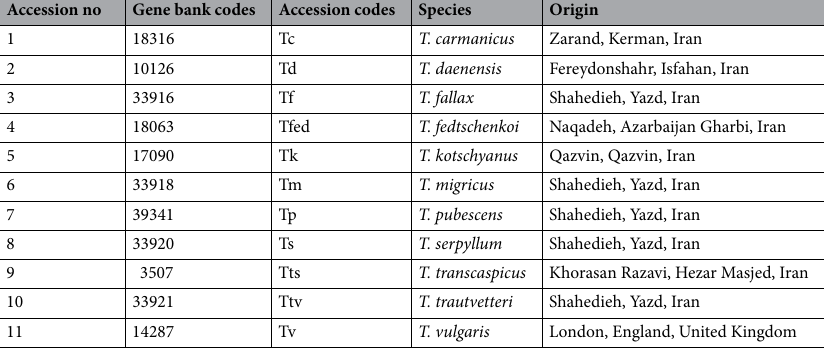
Table 7. Gene bank codes, accession codes and origins of Thymus